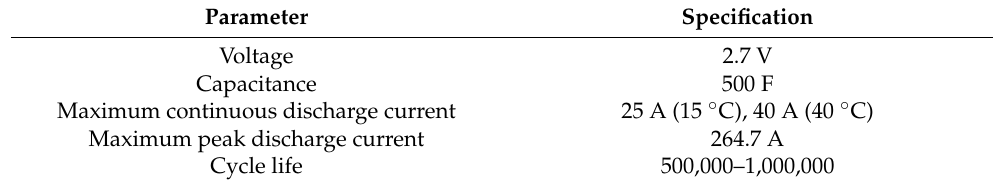
Table 2. Specification of supercapacitor.